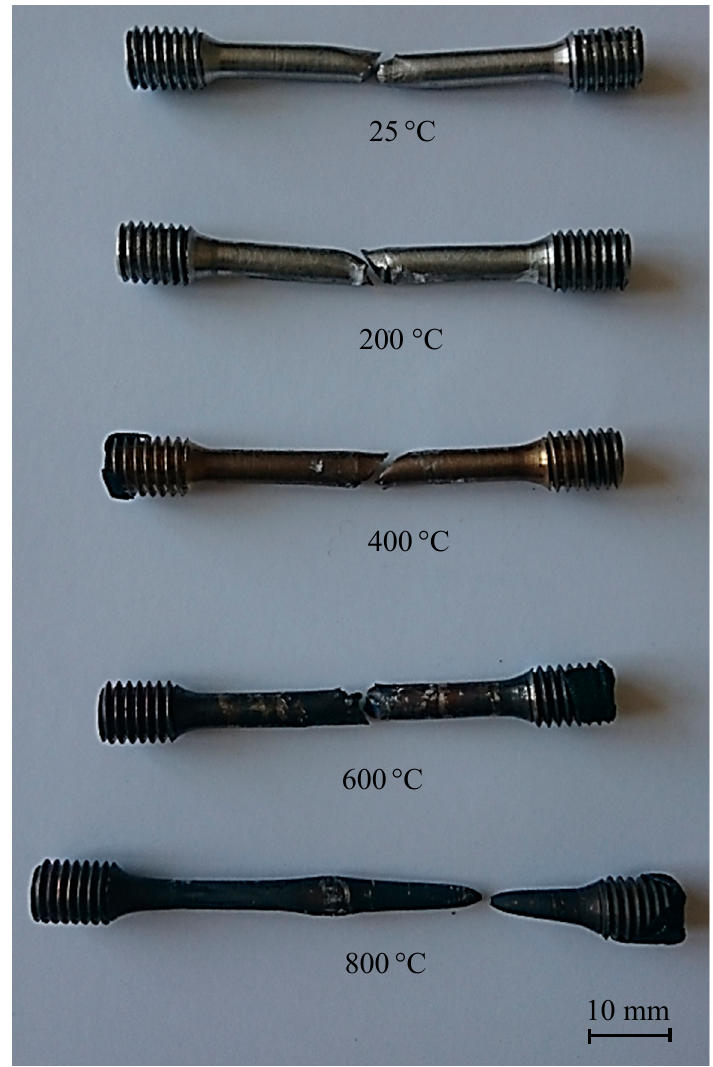
Figure 9. Failure mode of as-welded samples tensile tested at different temperatures.